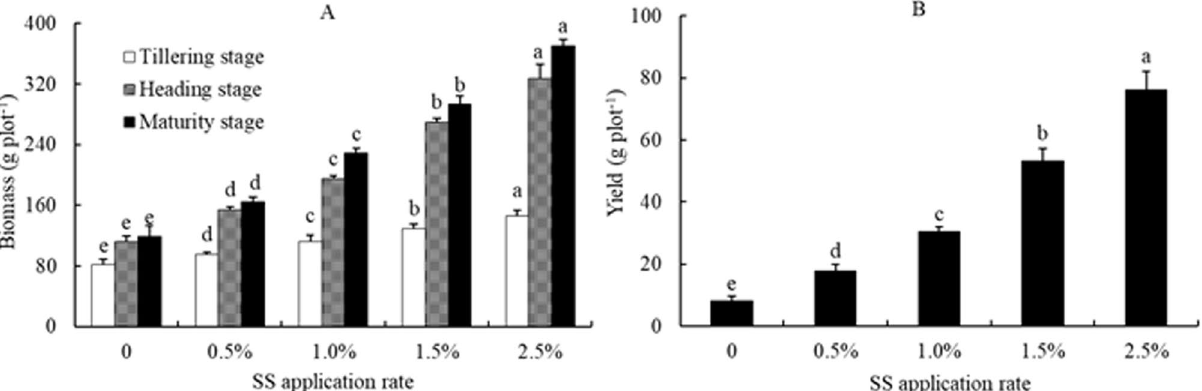
Figure 1. Effect of sewage sludge (SS) application on rice aboveground biomass ( A ) and yield ( B ) in salt- affected mudflat soil. Columns with different letters show significant difference between SS application rates at p < 0.05 by LSD’s multiple range